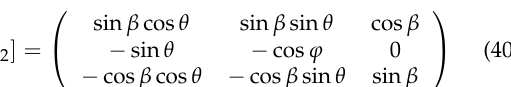
Fig. 4. Schematic diagram of actual drilling direction and drilling trend direction